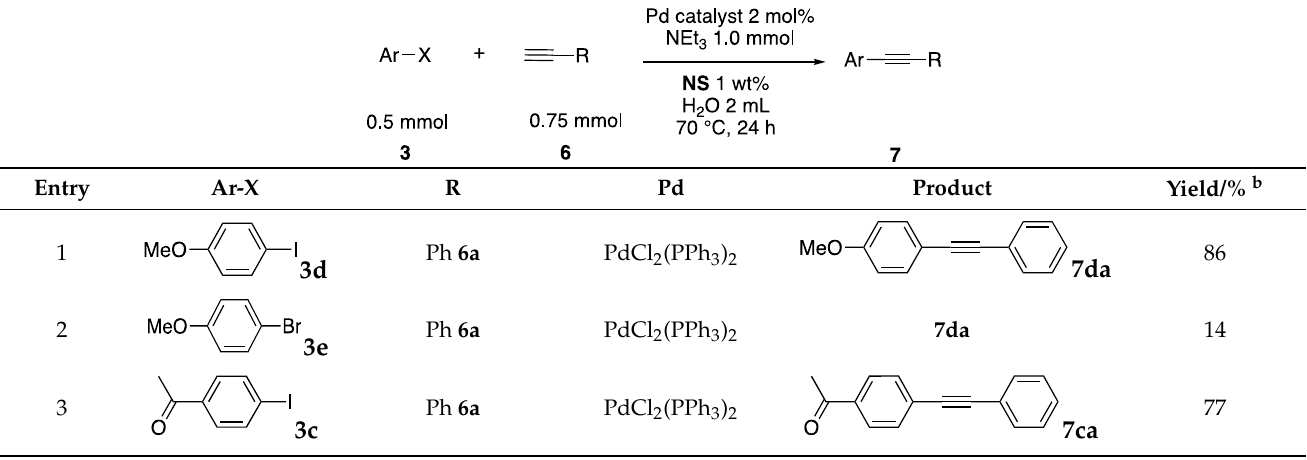
Figure 5. The appearance of the reaction mixture of Sonogashira coupling with NS . ( a ) The aqueous polymer solution. ( b ) Before the reaction with substrates. ( c ) During the reaction. ( d ) Cooled after the reaction with precipitated chunks. Table 7. Copper-free Sonogashira coupling in water using thermoresponsive copolymers a .